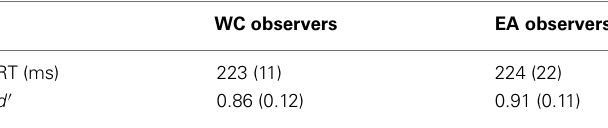
Table 1 | Performance ( d (cid:48) ) and reaction times (RT) according to the culture of the observer.